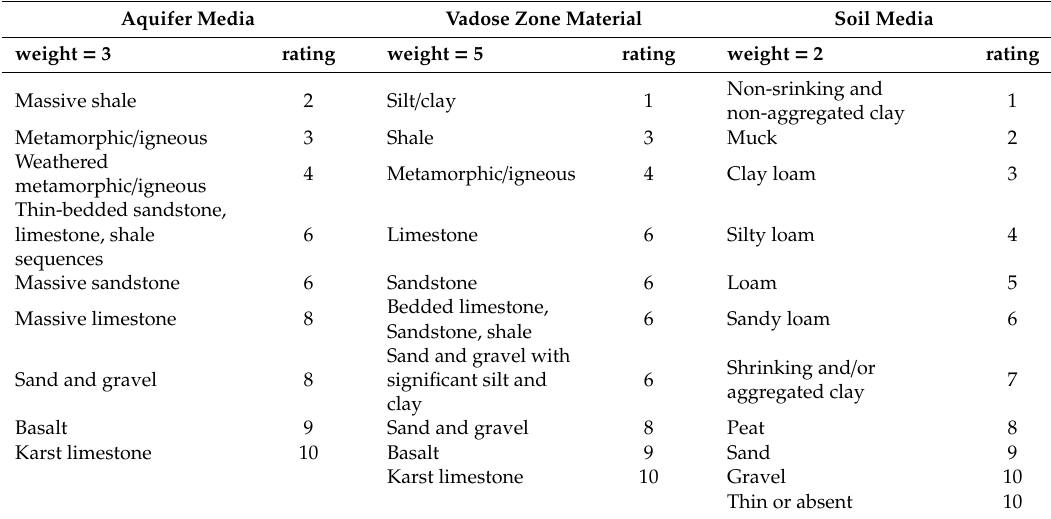
Table 3. DRASTIC A, I, S rating and